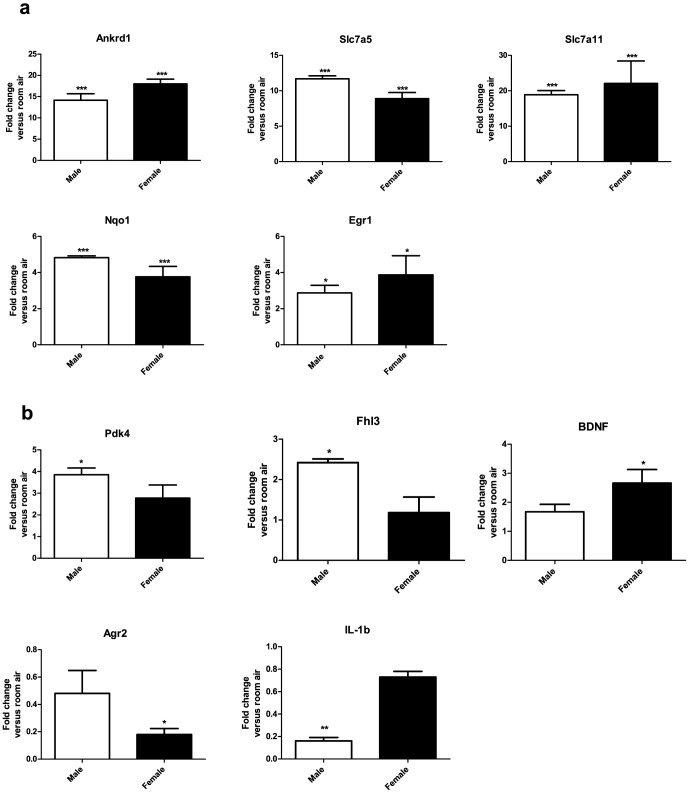
Real time RT-PCR analysis of mRNA from the lungs of male and female mice exposed to room air or hyperoxia for 48 h.Values are means ± SEM from n = 3 groups. Each group consisted of pooled RNA from four animals. Figure 5a: Real time RT-PCR analysis of differentially expressed genes common to both male and female mice. Significant upregulation over room air levels are indicated by * p<0.05 and *** p<0.001(one-way ANOVA). Figure 5b: Real time RT-PCR analysis of genes showing sex-specific changes. Fold change over room air levels are represented on the y-axis. Significant up or downregulation over room air levels are indicated by *p<0.05 and **p<0.01 (one-way ANOVA).